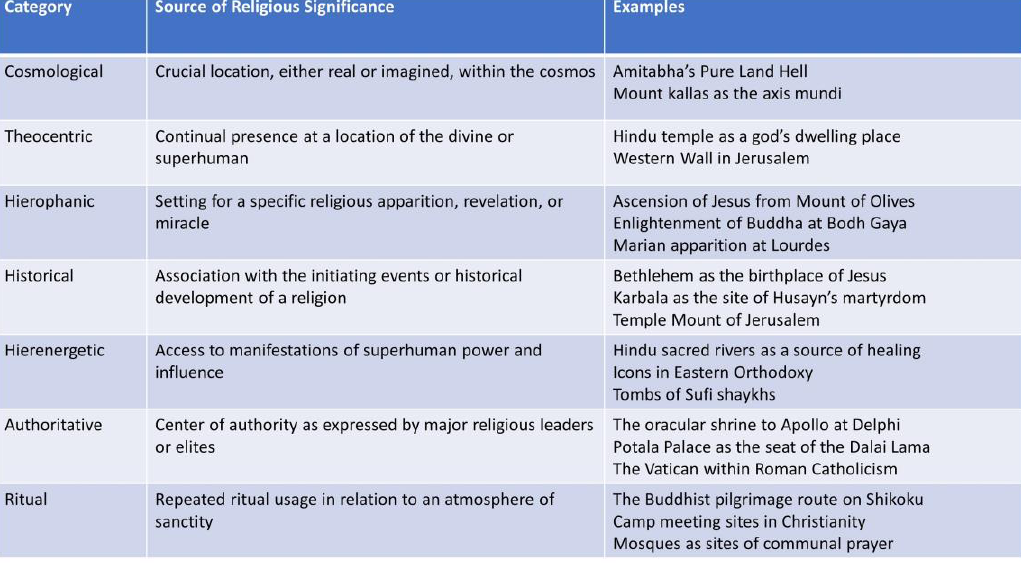
Figure 1. Categories of sacred spaces (Stump 2008).